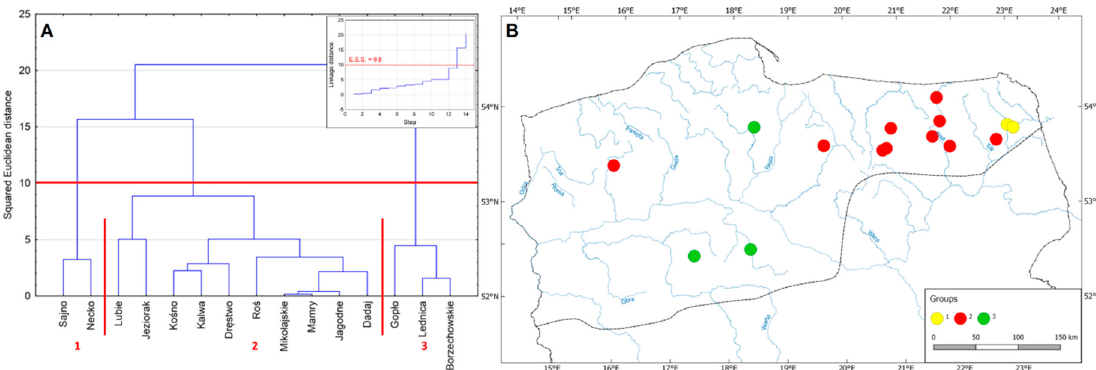
Figure 2. Dendrogram of grouping lakes by values of correlation coefficients of monthly AO indices with monthly water levels and the plot of the linkage distance ( A ); Spatial distribution of lakes in the performed grouping ( B